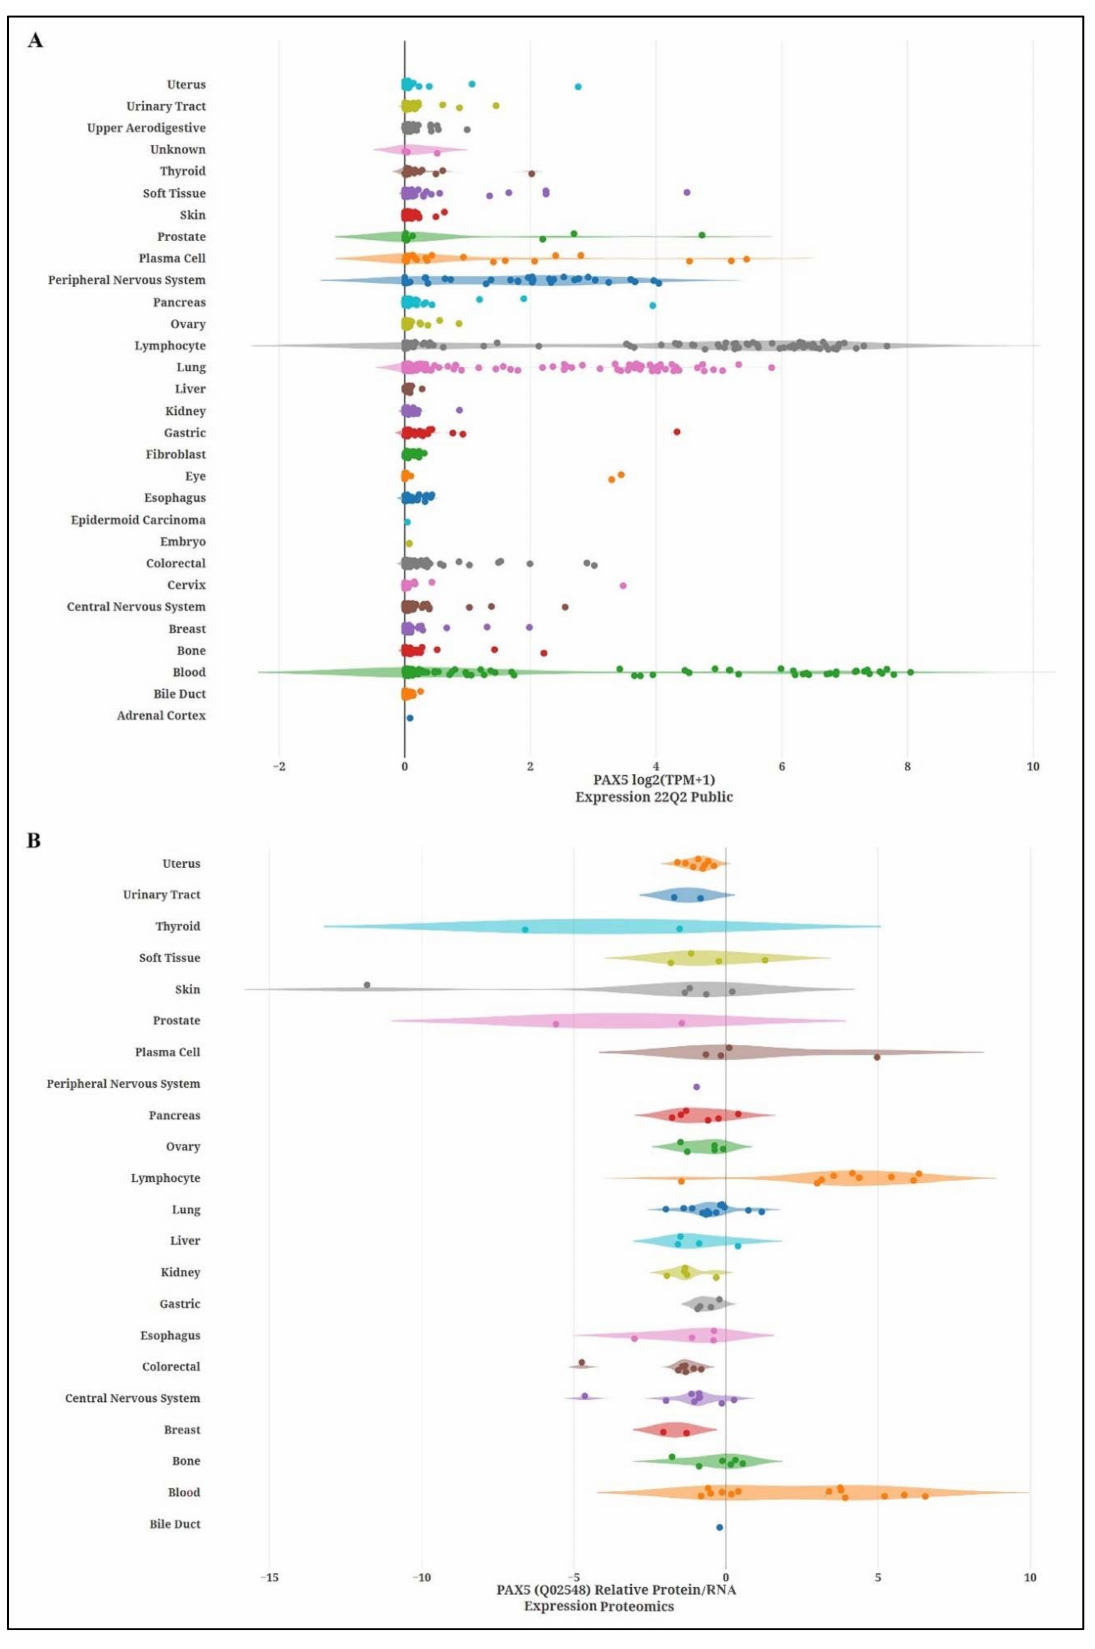
Figure 2. PAX5 expression profiles in human tissue collections. ( A ) Relative PAX5 transcription levels from deep sequencing data in over 560 cancer cell lines depict a significant level of PAX5 RNA